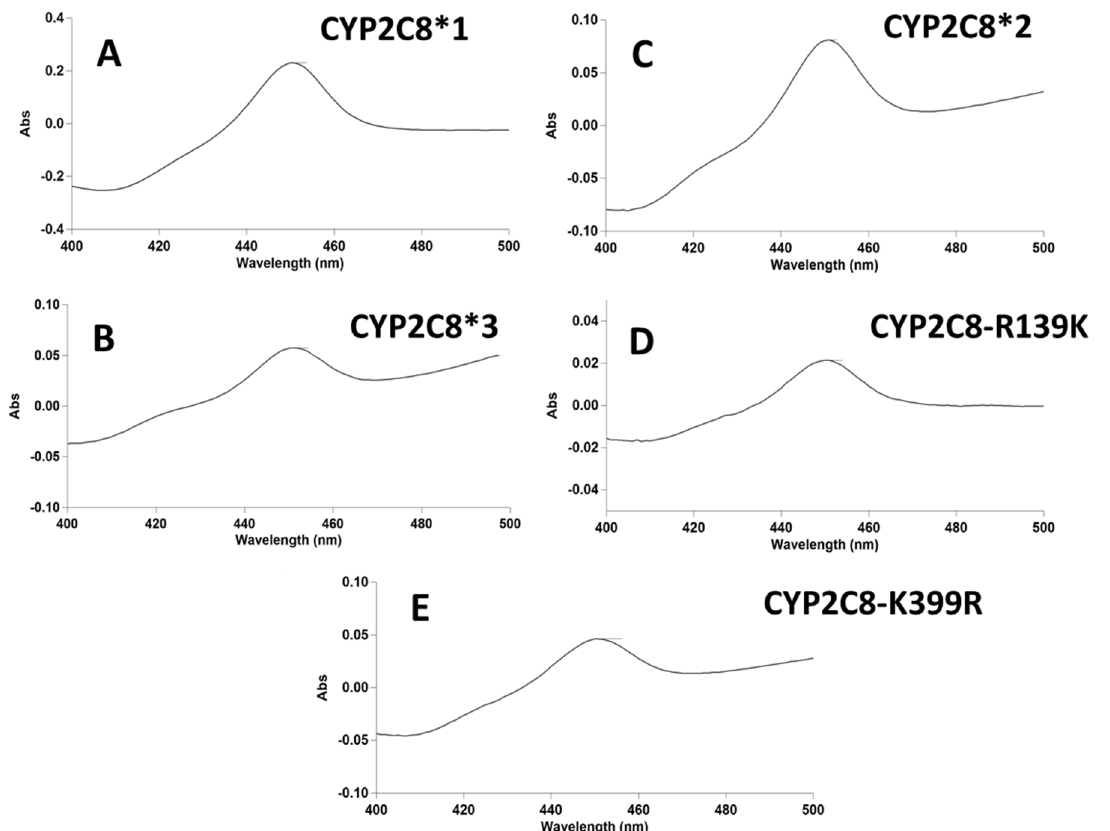
Figure 2. CO-binding difference spectra. ( A ) CYP2C8*1, ( B ) CYP2C8*2, ( C ) CYP2C8*3, ( D ) CYP2C8-R139K, and ( E ) CYP2C8-K399R.